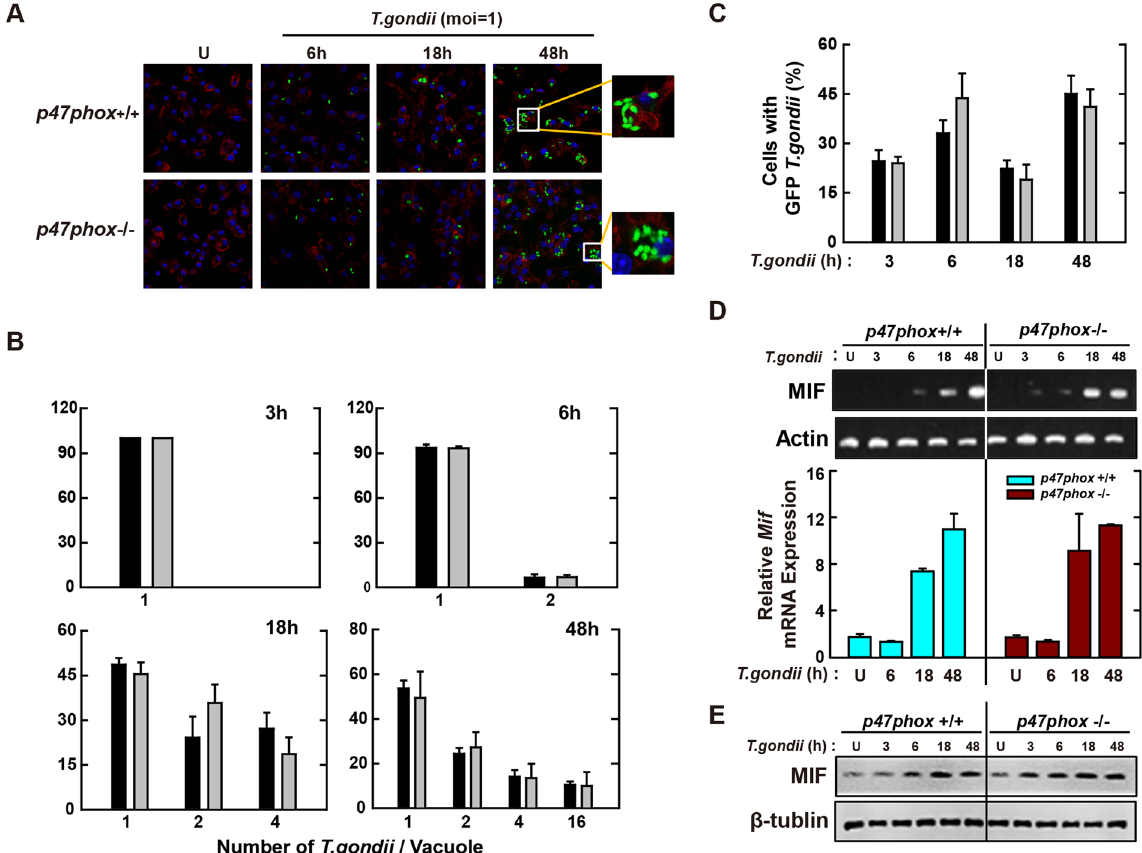
Figure 5. Macrophage-derived p47phox is not involved in antiparasitic defense during T . gondii infection. ( A – C ) BMDMs from p47phox + / + and p47phox − / − mice were infected with GFP-RH strain (moi = 1) for the indicated time periods. ( A ) Cells were fixed and stained with Texas Red ® -X phalloidin for labeling F-actin (red) for cytosolic fraction, and DAPI (blue) for nuclei and then analyzed for the number of GFP-RH strain using confocal microscopy ( B , C ) The number of GFP-RH strain per vacuole (for B) or of GFP-RH strain- infected cell (for C) were analyzed. Scale bar = 25 μ m. Data are representative of five independent experiments ( D , E ) BMDMs from p47phox + / + and p47phox − / − mice were infected with T . gondii RH strain (moi = 1) for the indicated time periods. ( D ) The mRNA expression for Mif and actb was determined using semiquantitative RT-PCR (top) or qPCR (bottom) analysis. ( E ) Immunoblot analysis was performed to determine protein expression of MIF and β -tubulin. Data are representative of three independent experiments and are presented as means ±